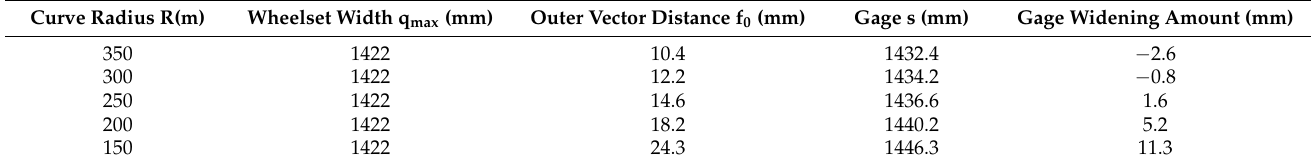
Table 13. Geometrically free-inscribed gage widening values.